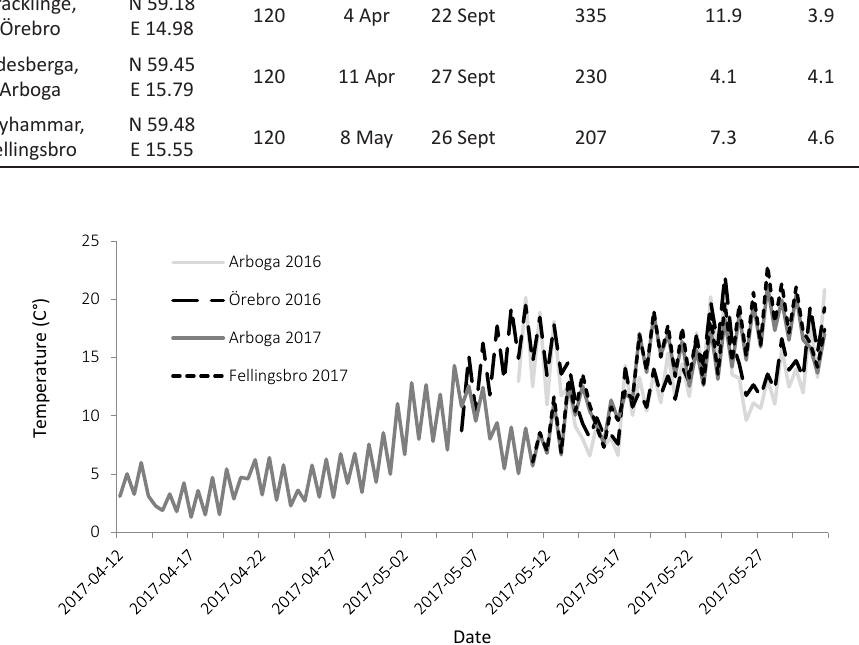
Fig. 1. Soil temperature at 2 cm depth at the four field